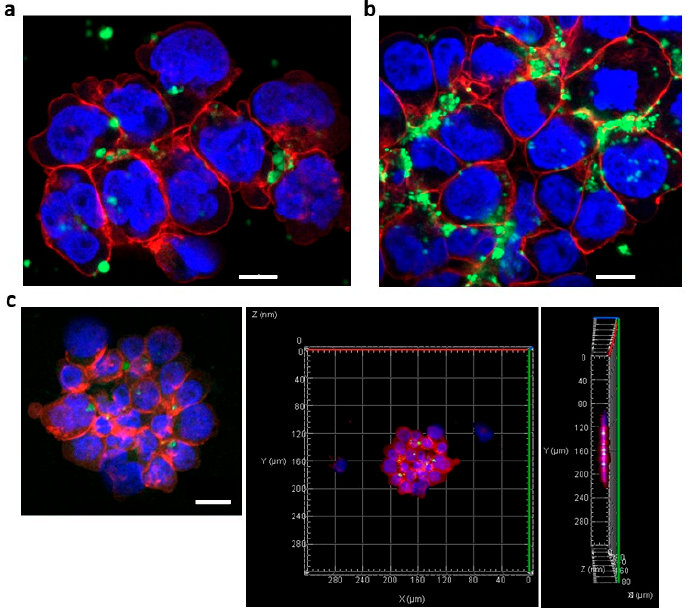
Figure 5. Confocal microscopic images of anti-CD63 mAb-conjugated siRNA complexes. ( a ) OPM-2-luc+ cells were treated with fluorescence-labeled anti-CD63 Ab-conjugated siRNA bound to linear Arg linkers. The anti-CD63 mAb-Arg linker:siRNA ratio was 5:1 (1500:300 (nM)). Scale bar, 10 μ m. ( b ) OPM-2-luc+ cells were treated with anti-CD63 mAb-conjugated fluorescence-labeled siRNA bound to branched Arg linkers. The anti-CD63 mAb-Arg linker siRNA ratio was 5:1 (1500:300 (nM)). Scale bar, 10 μ m. ( c ) Z-stack images of OPM-2-luc+ cells treated with anti-CD63 mAb-conjugated siRNA complexes. The anti-CD63 mAb-Arg linker siRNA ratio was 2.5:1 (750:300 (nM)). White dots in the right panel, incorporated siRNAs. Scale bar, 20 μ m. Red, rhodamine-phalloidin; blue, Hoechst 33342 (nuclei); green, FITC-labeled siRNAs.